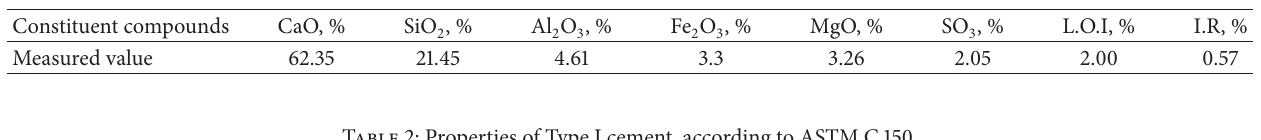
Table 1: Chemical contents of Type I cement, according to ASTM C 150.